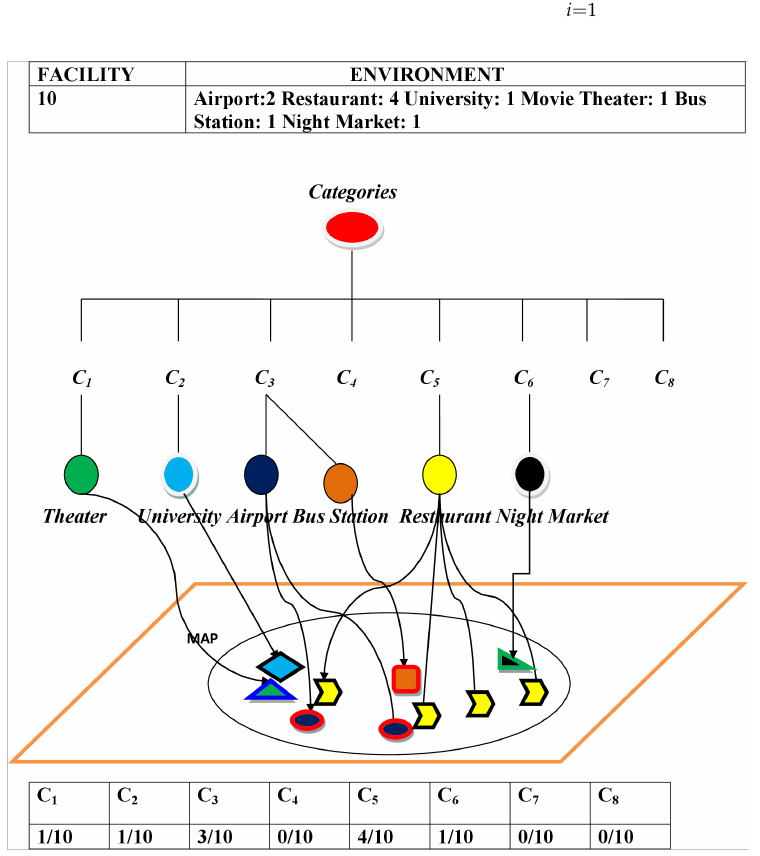
Figure 6. An Example of Surrounding Environment’s